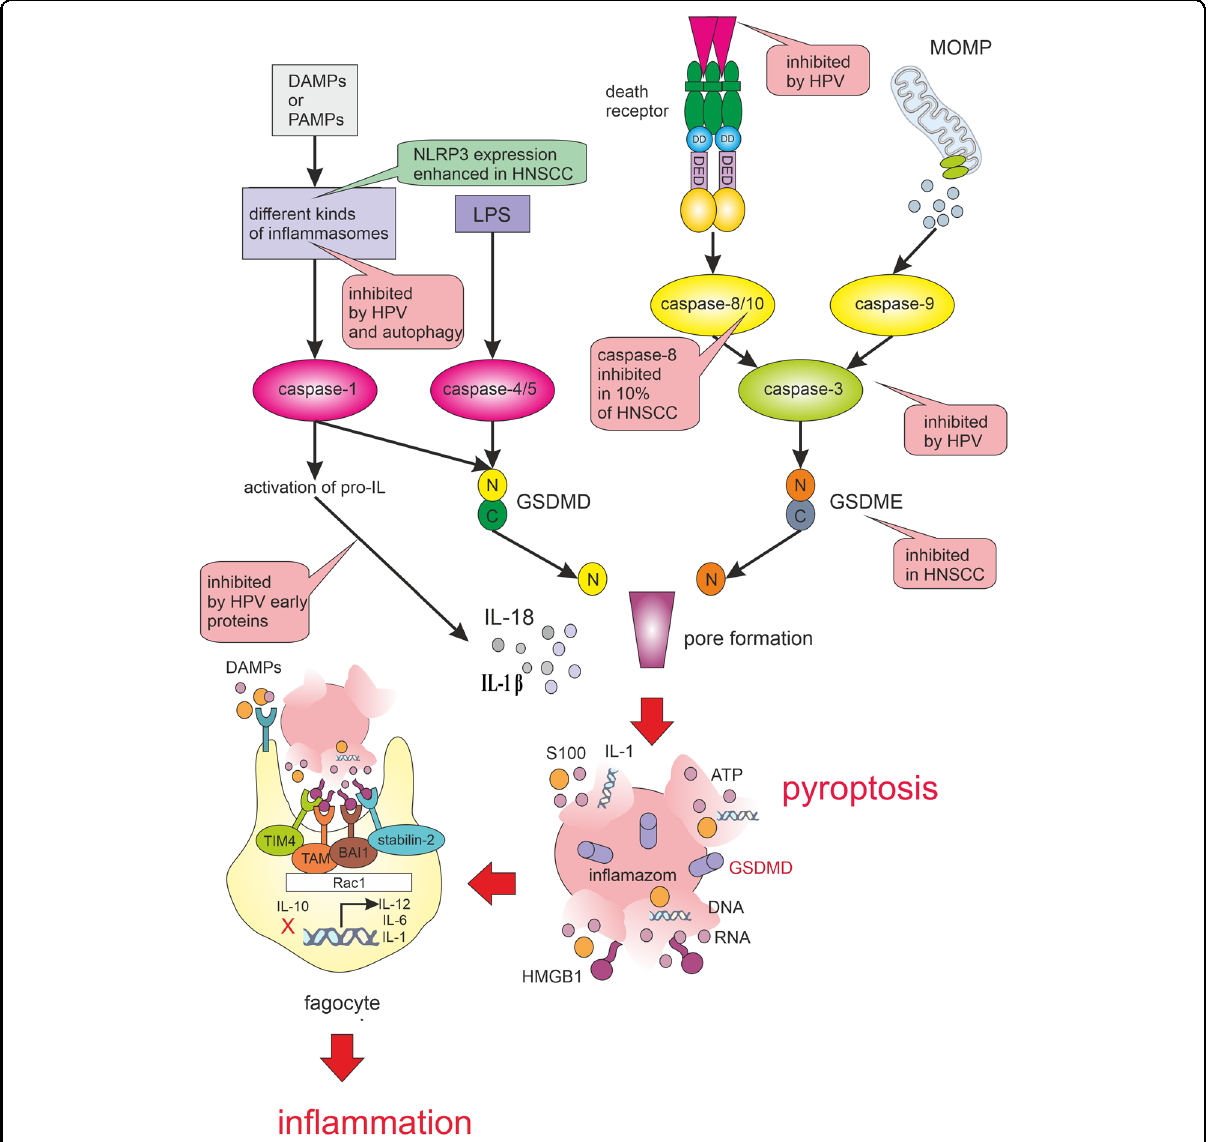
Fig. 2 Pyroptosis pathways. Pyroptosis is triggered when damage-associated molecular patterns (DAMPs) or pathogen-associated molecular patterns (PAMPs) activate the in fl ammasomes. Active in fl ammasomes lead to the cleavage and activation of caspase-1. The activated caspase-1 cleaves Gasdermin D (GSDMD). The N-fragment of GSDMD form cell membrane pores resulting in pyroptosis. Activated caspase-1 also promotes the maturation and secretion of interleukins IL-1 β and IL-18. When pathogen-derived lipopolysaccharide (LPS) binds to the precursor of caspase-4/5, it can also cause GSDMD cleavage and induction of pyroptosis. Another way to activate pyroptosis is caspase-3/Gasdermin E (GSDME) pathway. Caspase-3 can also be activated by mitochondrial outer membrane permeabilization (MOMP) and death receptor pathways. The activated caspase-3 then cleaves GSDME and produces GSDME N-fragments, The N-fragment of GSDME form cell membrane pores resulting in pyroptosis. Pyroptosis results in membrane rupture and the release of DAMPs that are detected by phagocyte receptors, such as TIM 4 (T cell immunoglobulin mucin receptor 4), BAI 1 (brain-speci fi c angiogenesis inhibitor 1), stabilin-2 and TAM (Tryo3-Axl-Mer receptor). DAMPs recognition leads to the production of pro-in fl ammatory interleukins (e.g. IL-1, IL-6) and IL-12, which activates NK cells and induces the differentiation of naive CD4 T cells. The pyroptotic signalling pathways are signi fi cantly in fl uenced by HPV infection and by the genetic background of HNSCC. Green bubbles indicate activation and pink inhibition of the